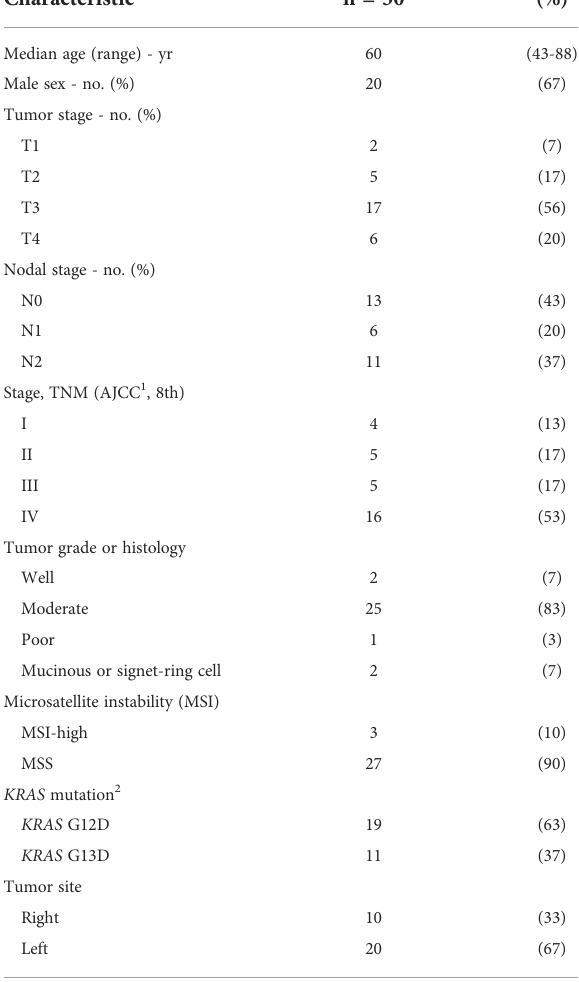
TABLE 1 Patient characteristics (n =